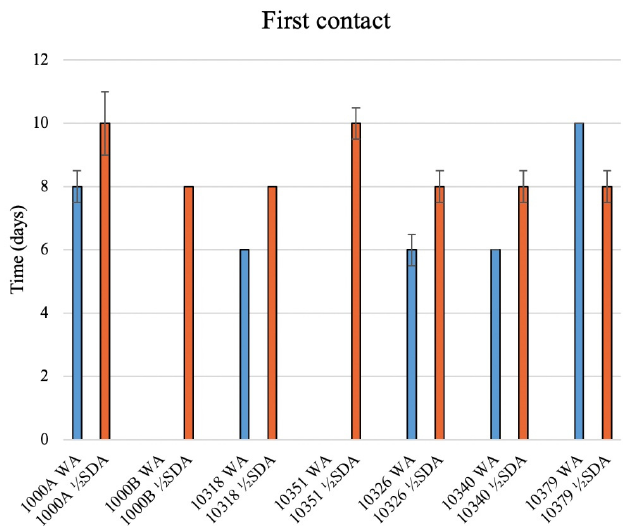
Figure 4. Time (days) elapsed since first visible contact with membrane of 7 dermatophyte strains in WA (light blue) and ½ SDA (orange). Error bars indicate the standard deviation of the three replicates used for the tests.